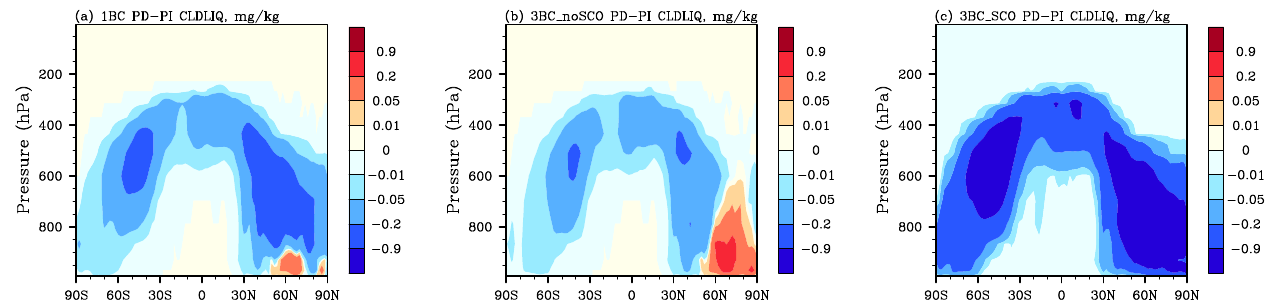
Fig. 6. PD–PI annual average changes of grid-mean liquid water mass mixing ratio (CLDLIQ) in mixed-phase clouds from 1BC (a) ,